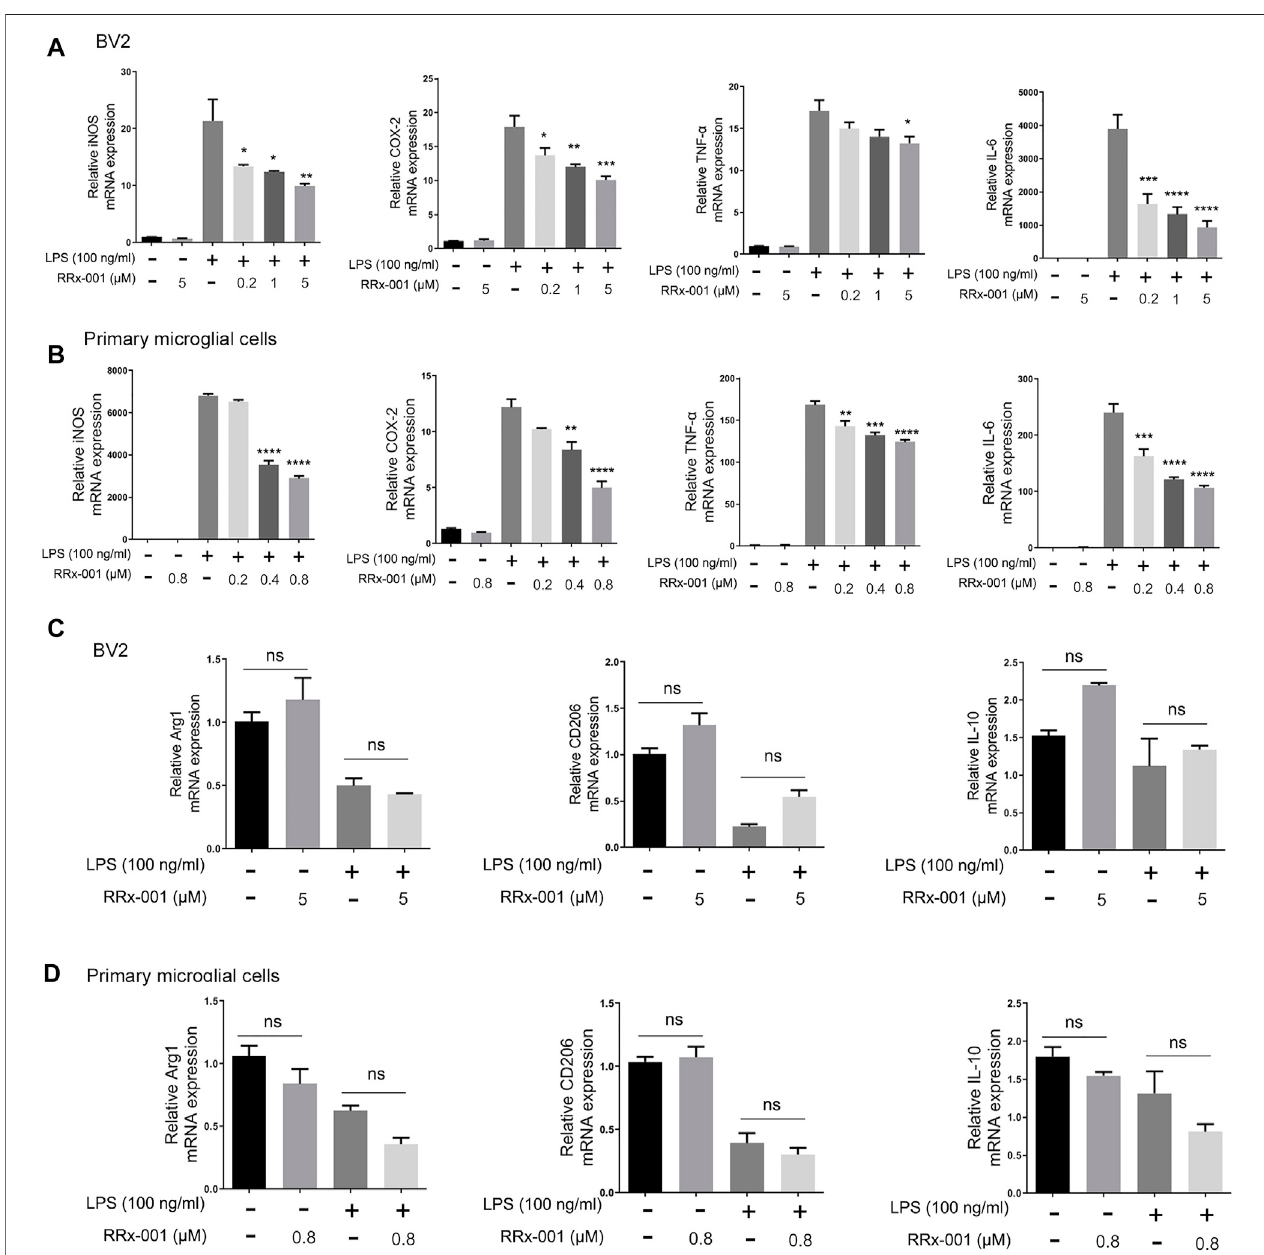
FIGURE 2 | RRx-001 inhibited the transcriptional activation of LPS-induced proin fl ammatory cytokines in BV2 cells and primary microglia. (A,B) BV2 cells were pretreated with RRx-001 at proportionate doses of 0.2, 1 and 5 µM and primary microglia with RRx-001 at doses of 0.2, 0.4 and 0.8 µM for 12 h and followed by LPS (100 ng/ml)stimulationfor6 h.AfterthetotalRNAwasextracted,themRNAlevelsofiNOS,COX-2,TNF- α andIL-6weredeterminedwithqRT-PCR.Thedatafromthree independentexperiments wereshownasthemeans±SEM.One-wayANOVAfollowedbyBonferroni ’ spost-hoctestwasusedformultiplecomparisonsbetween groups, * p < 0.05, ** p < 0.01, *** p < 0.001, **** p < 0.0001, compared with those treated with LPS alone. (C,D) The mRNA levels of Arg1, IL-10 and CD206 in BV2 cells and primarymicrogliatreatedasdescribed inaandb weredeterminedwithqRT-PCR.Thedatafromthreeindependentexperimentswereshown asthemeans±SEM. ns, not signi fi cantly